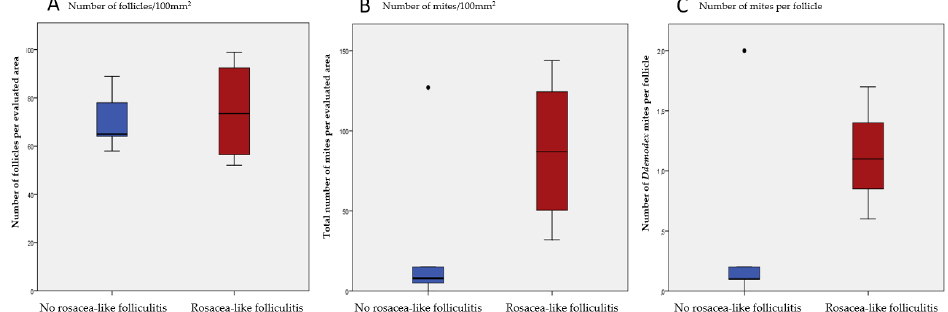
Figure 3. Quantification of Demodex mites and follicles in atopic dermatitis (AD) patients with (red) and without (blue) rosacea-like folliculitis. ( A ) There was no significant difference between the counted number of follicles in the rosacea-like folliculitis group and the control group. ( B ) Patients with rosacea-like folliculitis showed higher numbers of Demodex mites within an area of 100 mm 2 . ( C ) A higher number of mites per follicle was observed in patients with rosacea-like folliculitis than in controls. All results are computed as mean values including standard deviation (SD). Due to low patient numbers results are not significant but show a clear trend.